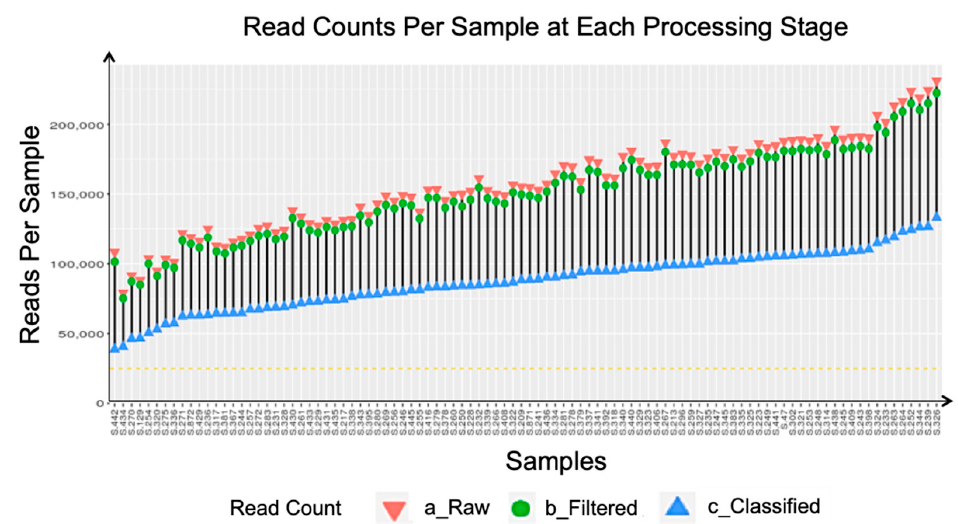
Figure A1. Sequence counts per sample for raw, filtered, and classified sequences, ordered by increasing classified sequence counts. The dashed gold line indicates the 25,000 sequence threshold used for rarefaction.